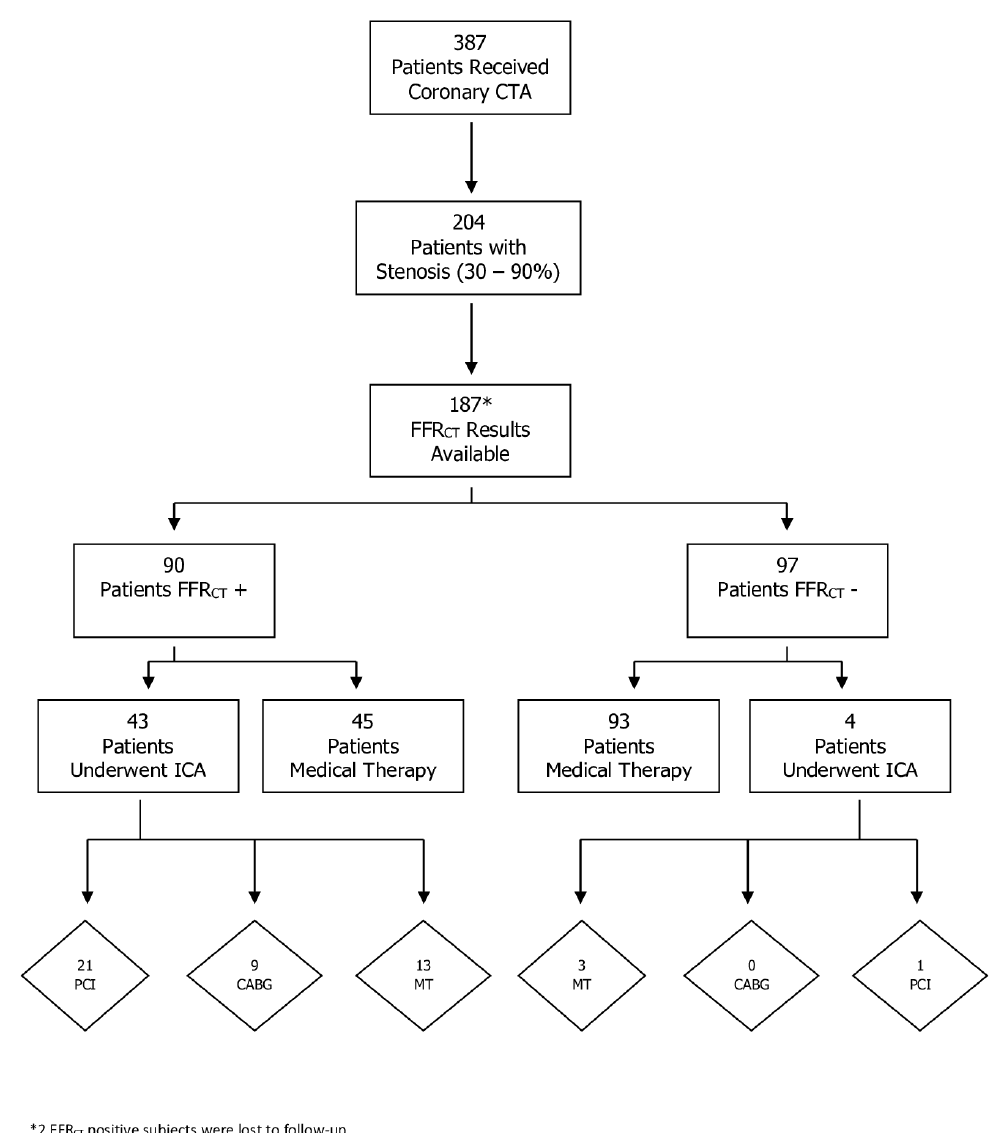
Figure 3. Flowchart for patients with intermediate coronary artery disease and fractional flow reserve from coronary computed tomography angiography (FFR CT ) availability. CTA, computed tomography angiography datasets; ICA, invasive coronary angiography; PCI, percutaneous coronary intervention; CABG, coronary artery bypass graft surgery; MT, medical therapy.